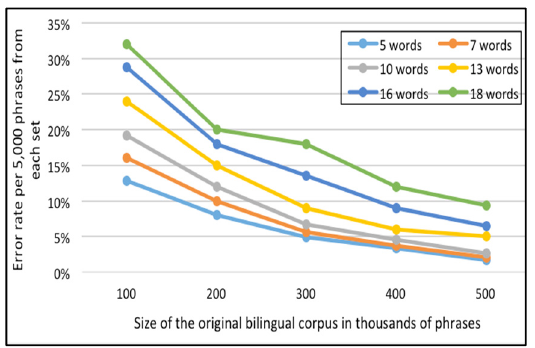
Figure 12. Error rate per 5000 phrases of each set, for the English-French corpora.